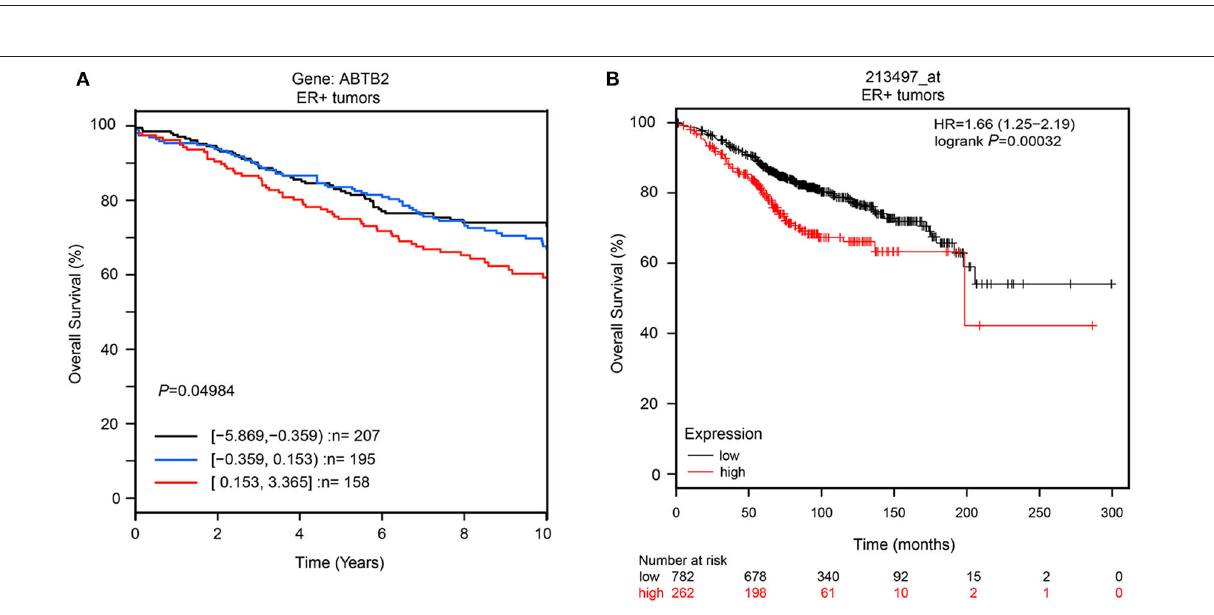
breast cancer prognosis, and the mechanism of ABTB2 -inducing resistance to epirubicin’s cytotoxicity. For now, neoadjuvant endocrine plus targeting therapy is used in more and more patients, and predictive biomarkers of this regimen need to be